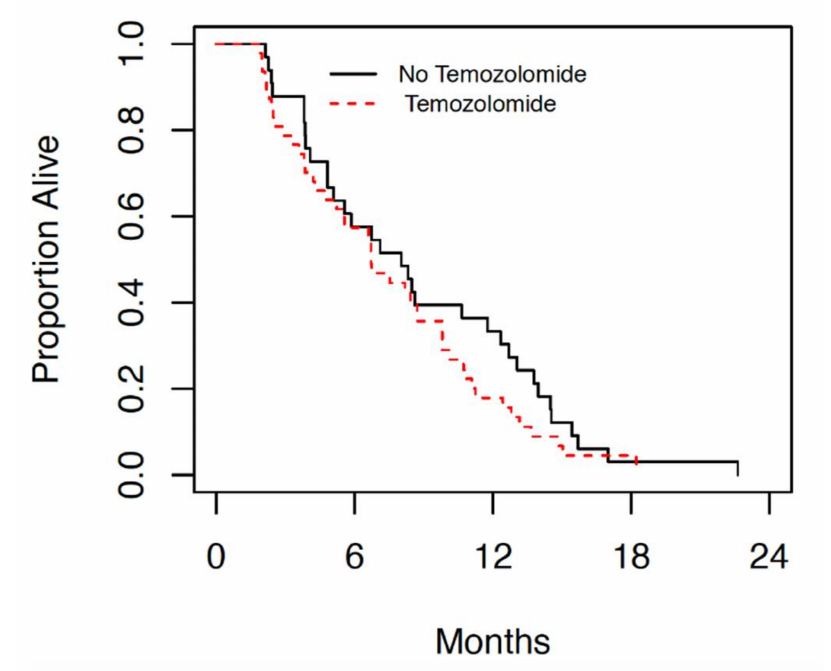
Figure 1. Median overall survival in patients treated with radiation alone (no temozolomide) and those who were treated with concurrent chemoradiation